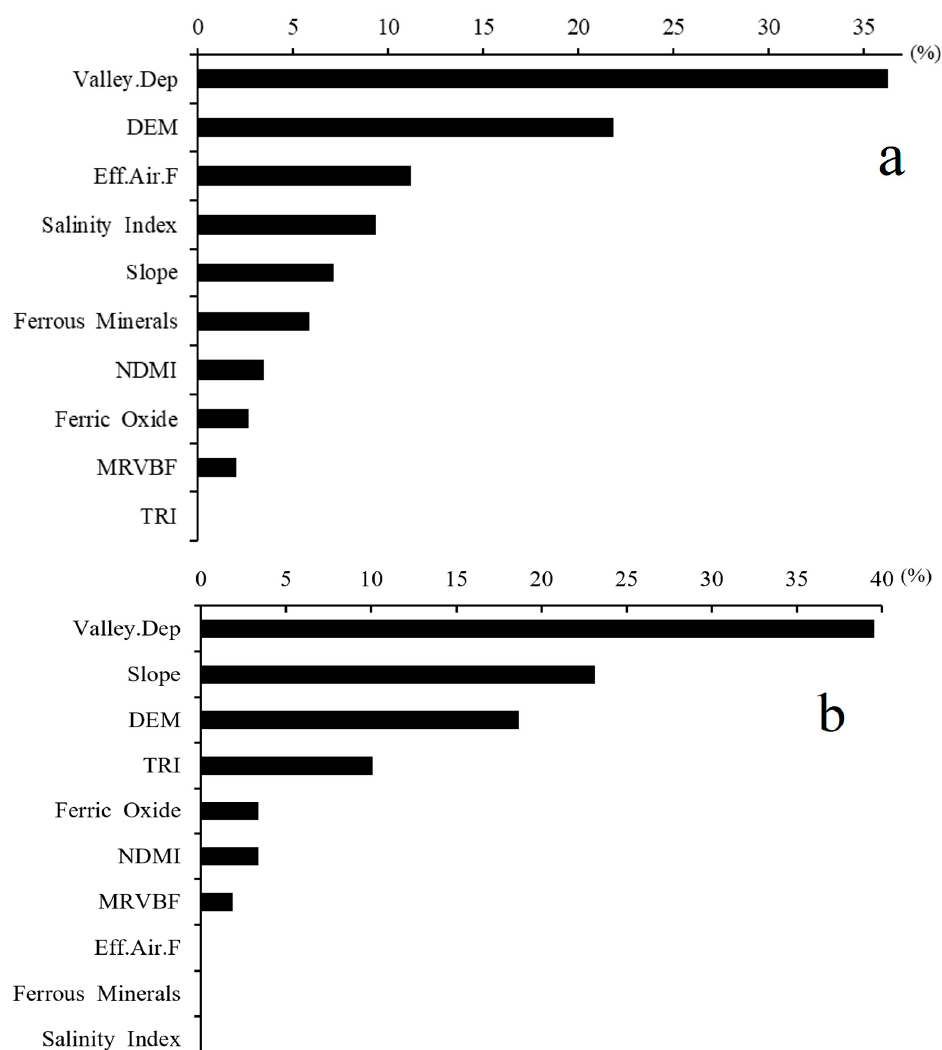
Figure 7. Importance variable analysis for predicting CEC by the best model for training, RF ( a ), and validation dataset, Cu ( b ); Valley. Dep: Valley depth; DEM: digital elevation model; TRI: Terrain ruggedness index; NDMI: Normalized difference moisture index; MRVBF: Multiresolution of ridge to flatness index, Eff.Aif.F: Effective airflow height.